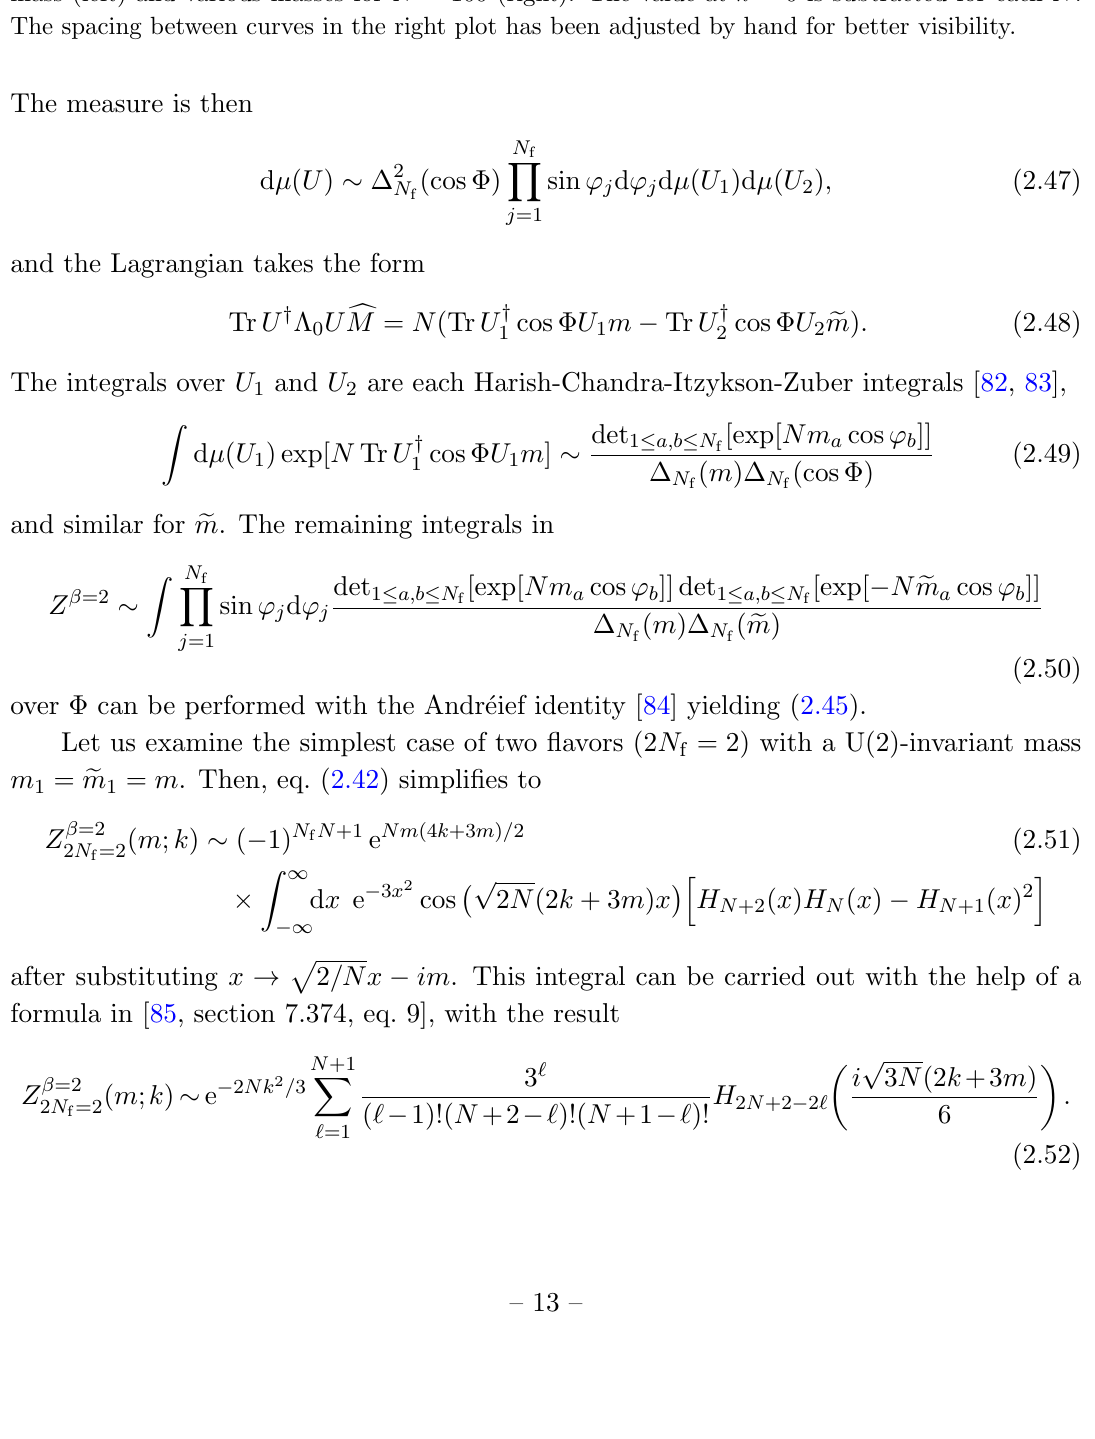
Figure 2 . The free energy for two (cid:13)avors with equal mass in the chiral limit for varying N for zero mass (left) and various masses for N = 100 (right). The value at k = 0 is subtracted for each N . The spacing between curves in the right plot has been adjusted by hand for better